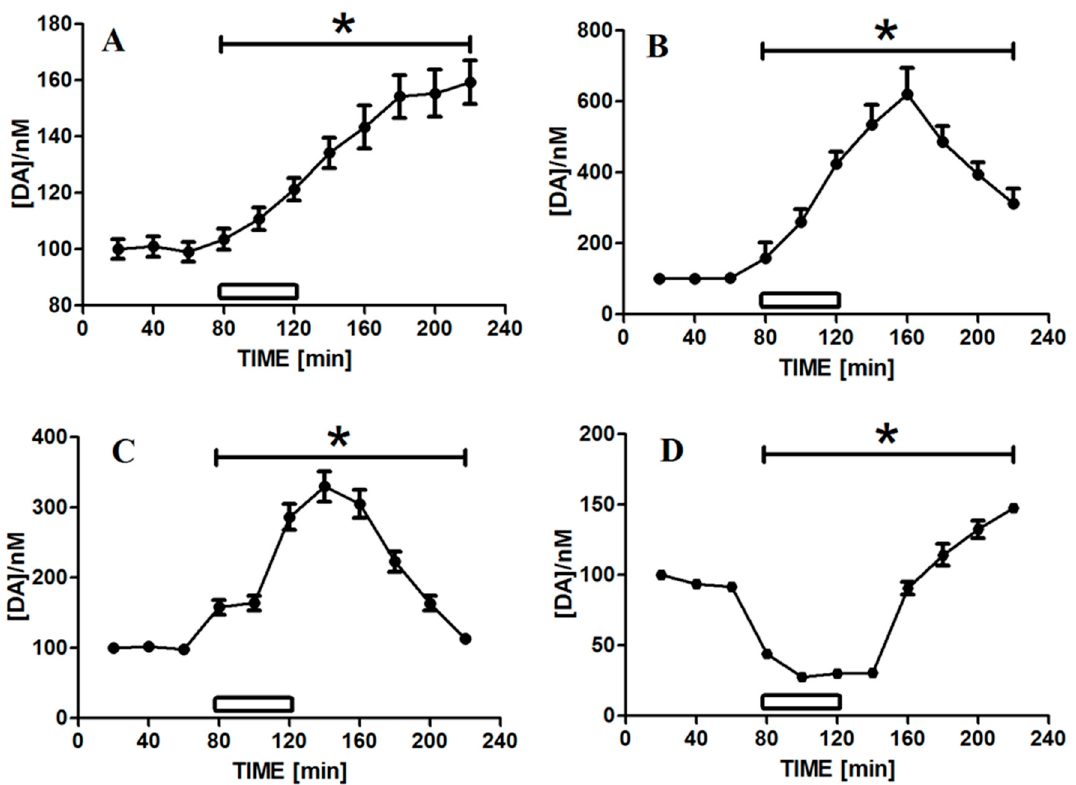
Figure 8. Effect of SNAP ( A ), PI ( B ), 4-MeO-PI ( C ) and 4-NO 2 -PI ( D ) perfusion on DA concentrations in dialysates from PC12 cells suspension. All NO-donors (1.0 mM, n = 3 cell suspensions) were infused for 60 min (open bar, 80–120 min). Dialysates were collected, at 20-min intervals before, during and after NO-donor infusion. The collected dialysates were analysed by HPLC. Values are the mean ± S.E.M. * p < 0.05 compared with baseline values.